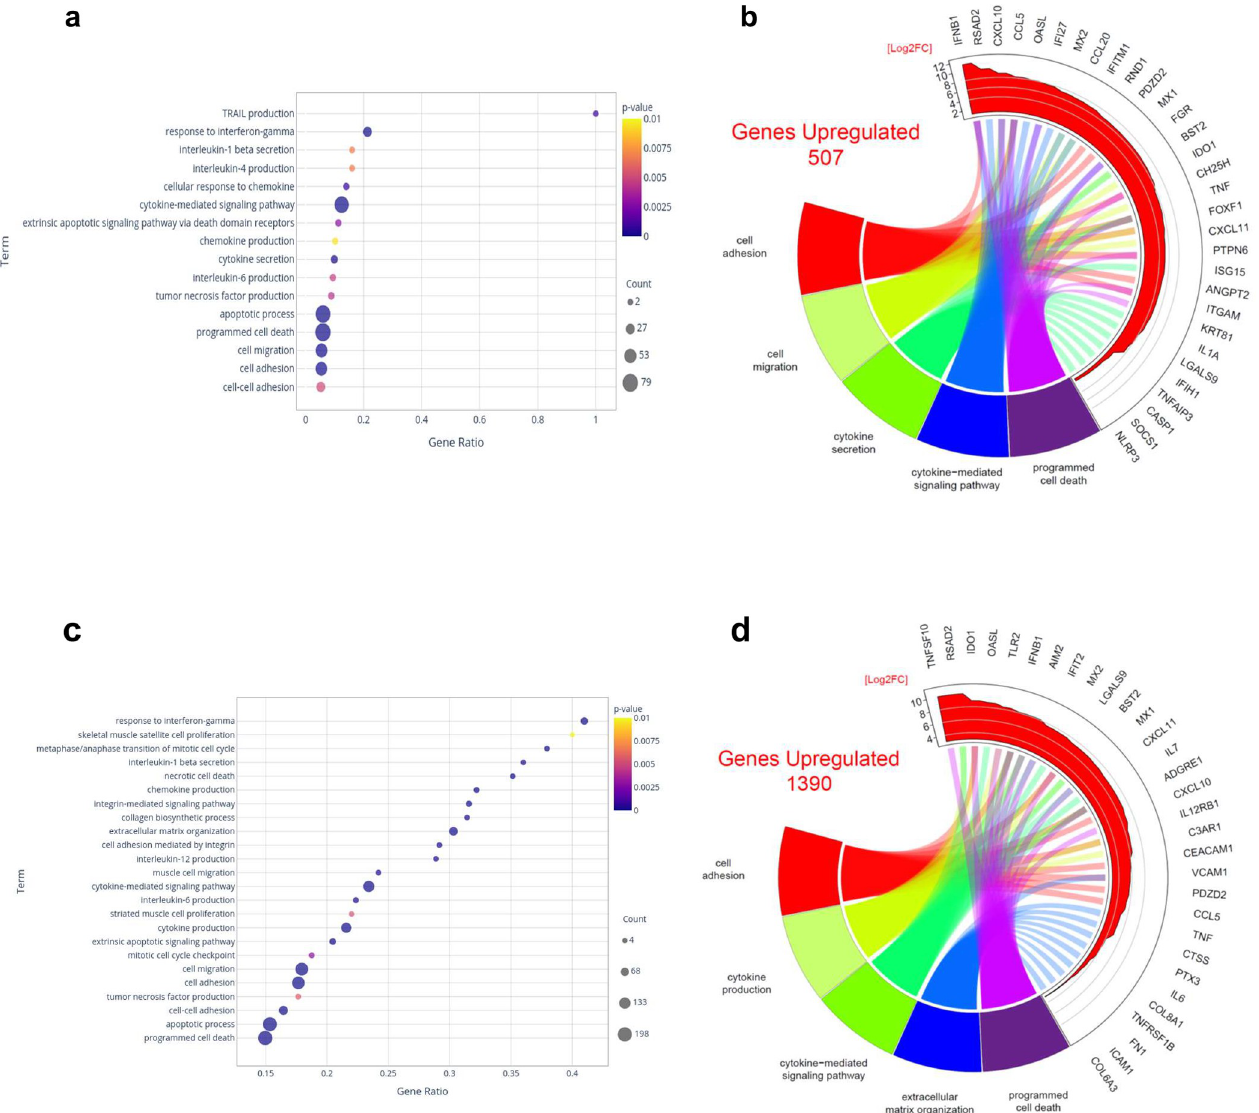
Fig 3. In vitro Zika virus infection of human myoblasts and myotubes upregulates gene expression related to cytokine production and signaling, as well as cell adhesion, cell migration and cell death. ( A ) Dot plot illustrating the GO biological process annotations upregulated in myoblasts infected with ZIKV. ( B ) Circos plot representing the total numbers of genes upregulated in ZIKV-infected myoblasts and the 10 most highly upregulated genes among 5 selected GO biological processes. ( C ) Dot plot illustrating the GO biological process annotations upregulated in ZIKV-infected myotubes. ( D ) Circos plot representing the total number of genes upregulated in ZIKV-infected myotubes and the 10 most highly upregulated genes among 5 selected GO biological processes. The whole list of differentially expressed genes can be seen in S1 Table.